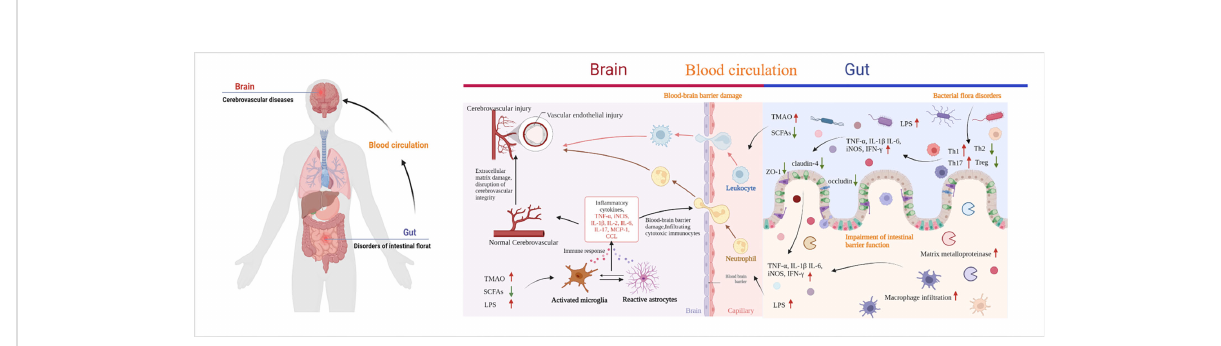
FIGURE 4 Pathways of cerebrovascular injury due to intestinal microbial imbalance. TMAO, trimethylamine-N-oxide; SCFAs, short-chain fatty acids; LPS, lipopolysaccharide; TLR4, toll-like receptor 4; CCL, chemokines. By Figdraw and